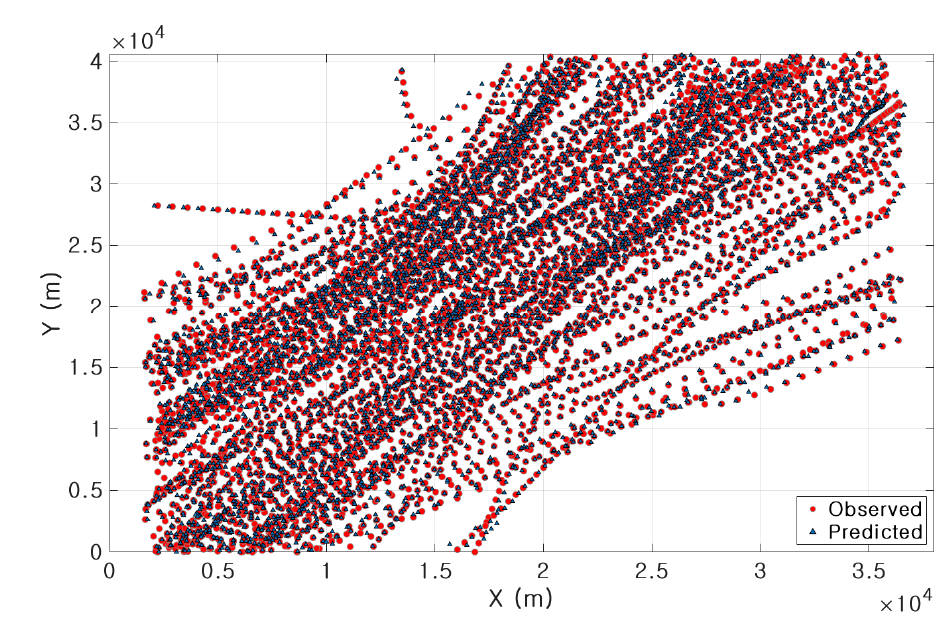
( e ) Predicted trajectory for group A using GRU. Figure 8.